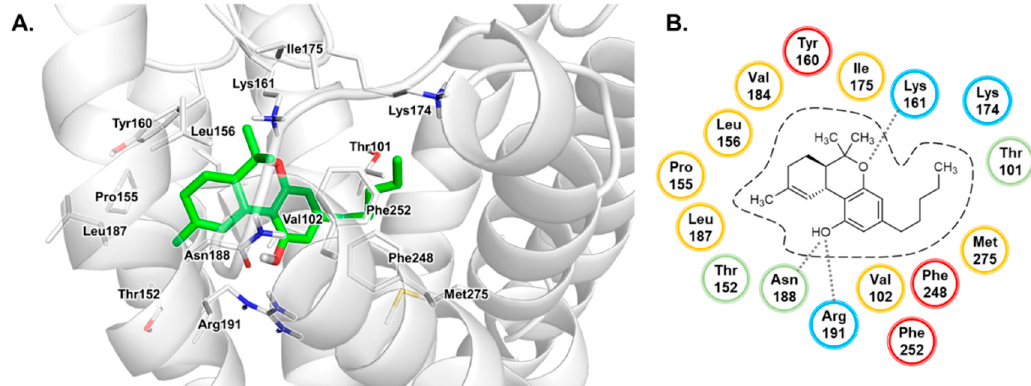
Figure 8. Proposed binding mode of ∆ 9 -tetrahydrocannabinol (THC) in the homology model of human GPR18. ( A ) The receptor is displayed in cartoon representation, the amino acid residues (white) and THC ( 1 , green) are shown as stick models. Oxygen atoms are colored in red, nitrogen atoms in blue, sulfur atoms in yellow. ( B ) Schematic 2D representation of the binding pocket. For color code, see Figure 2.